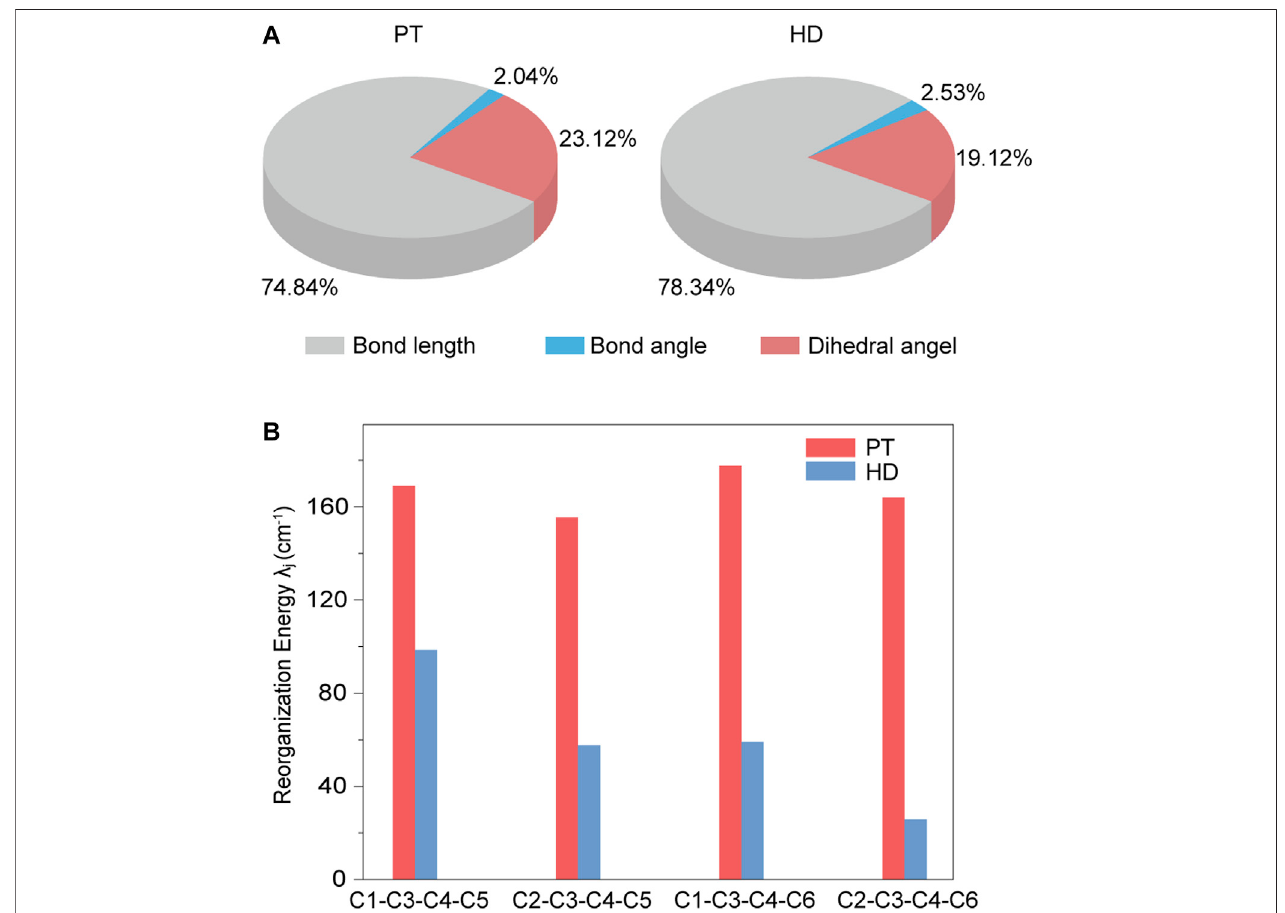
FIGURE 5 | The calculated (black) and experimental (red) spectrum of phosphorescence for HD.